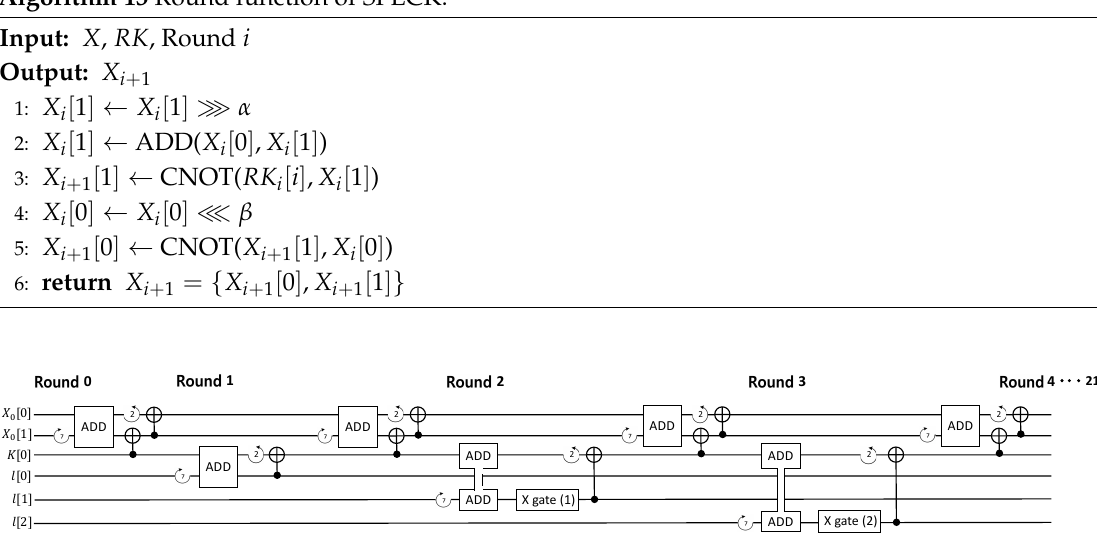
Figure 14. Quantum circuit for SPECK-32/64.